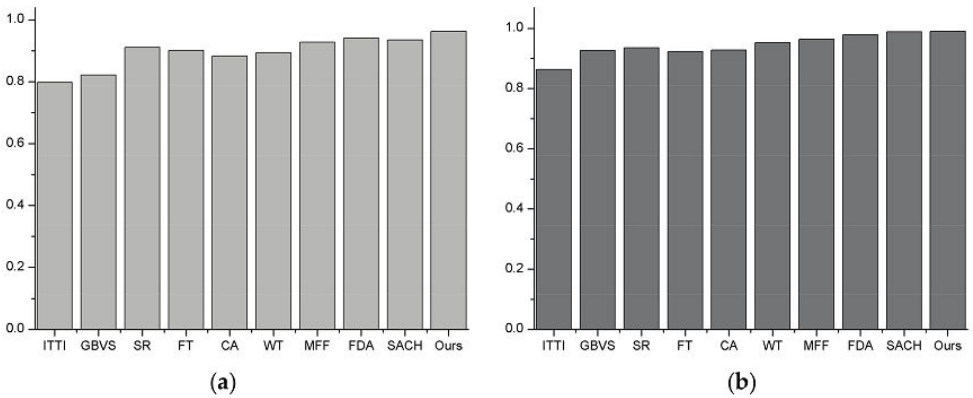
Figure 10. AUC of ROC curves of our proposed model and nine competing models on ( a ) SPOT 5 and ( b ) Google Earth